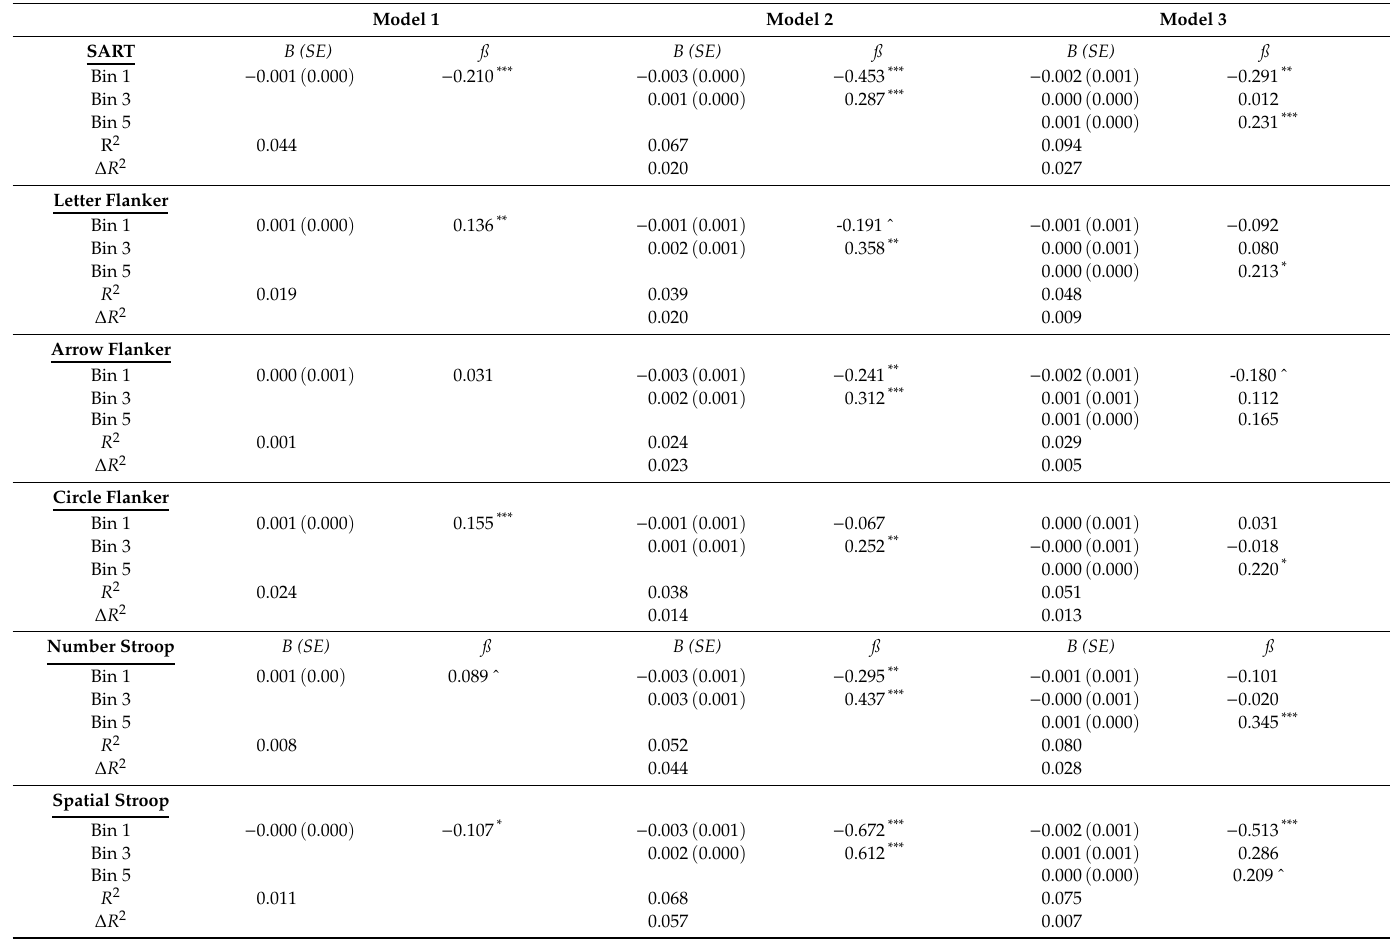
Table 4. Hierarchical regressions of TUTs regressed on Bins 1, 3, and 5, for each